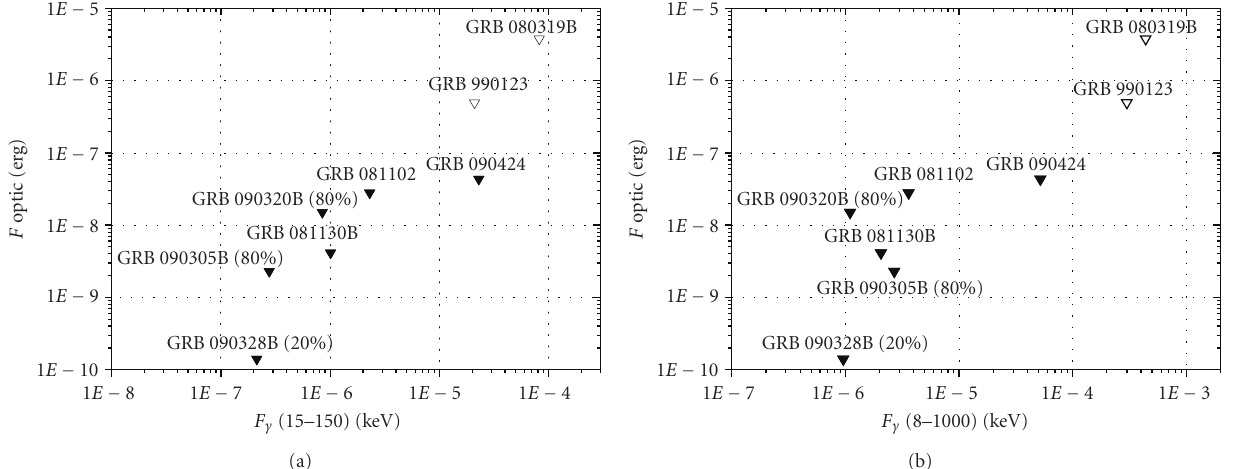
Figure 1: Summary results of synchronous observations of a gamma-ray burst: dependence plotted as a function of gamma-ray fluence in the soft (15–150keV) and hard (8–1000keV) energy interval.